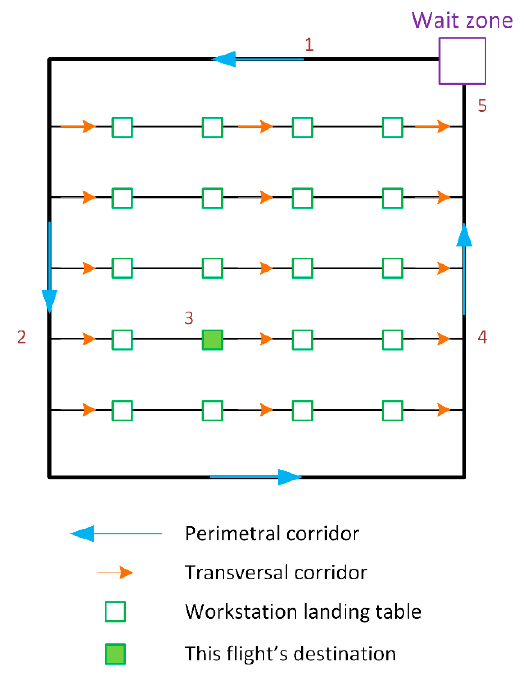
Figure 5. Navigation strategy.